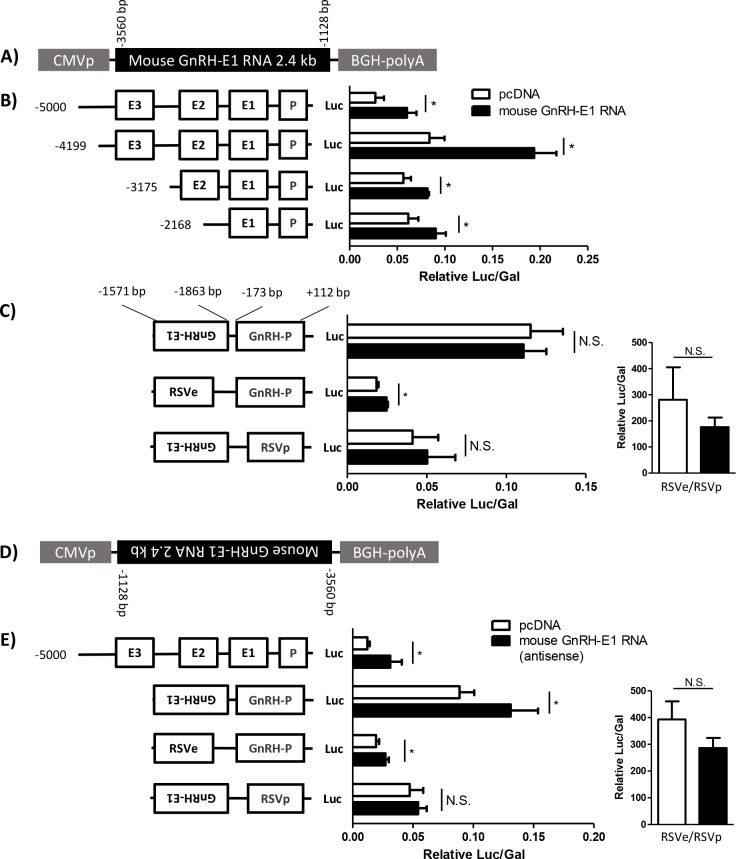
The effect of mouse GnRH-E1 RNA over-expression on Gnrh1 gene transcriptional activity in GN11 cells.(A) A schematic diagram of the expression plasmid carrying the -3560 bp/-1128 bp segment from upstream of the mouse Gnrh1 TSS, which contains the full-length mouse GnRH-E1 RNA that is integrated in the forward orientation. Expression of the sense GnRH-E1 RNA is driven by the CMV promoter (CMVp) and terminated by a plasmid-specific 3’ polyadenylation element (BGH-PolyA). B-C) GN11 neurons were transiently co-transfected with either empty pcDNA2.1 vector (white bars) or expression plasmid carrying the forward mouse GnRH-E1 RNA (black bars) for over-expression and the luciferase reporter plasmids as indicated. (B) GN11 cells were co-transfected with luciferase reporter plasmids containing -5000 bp, -4199 bp, -3175 bp, or -2168 bp of the rat Gnrh1 regulatory region. Each luciferase reporter plasmid contains the indicated Gnrh1 enhancers (E1, E2 and E3) and Gnrh1 promoter (P). (C) GN11 cells were co-transfected with luciferase plasmids carrying the rat Gnrh1 enhancer 1 and promoter (GnRH-E1/GnRH-P), RSV enhancer and the rat Gnrh1 promoter (RSVe/GnRH-P), the rat Gnrh1 enhancer 1 and RSV promoter (GnRH-E1/RSVp), or the RSV enhancer and promoter (RSVe/RSVp) control (inset). For reporter plasmids carrying GnRH-E1, the rat Gnrh1 enhancer is integrated in the reverse orientation in the plasmid. (D) A schematic diagram of the antisense GnRH-E1 RNA expression plasmid carrying the full-length mouse GnRH-E1 RNA that is integrated in the reverse orientation, driven by CMVp and terminated by BGH-PolyA. (E) The antisense GnRH-E1 RNA expression plasmid (black bars) or empty pcDNA2.1 expression plasmid (white bars) were transiently co-transfected with a reporter plasmid carrying the -5 kb rat Gnrh1 gene regulatory region, GnRH-E1/GnRH-P, GnRH-E1/RSVp, or RSVe/RSVp control (inset). Since the RSVe/RSVp is a very strong reporter, relative luciferase/β-galactosidase values for the RSVe/RSVp reporter are graphed separately for clarity in C and D. Luciferase/β-galactosidase values were normalized to pGL3. Data are displayed as the mean ± SD. Asterisks indicate statistical significance determined using Student’s T-test comparison between pcDNA2.1-transfected and GnRH-E1 RNA-transfected cells, where p<0.05.